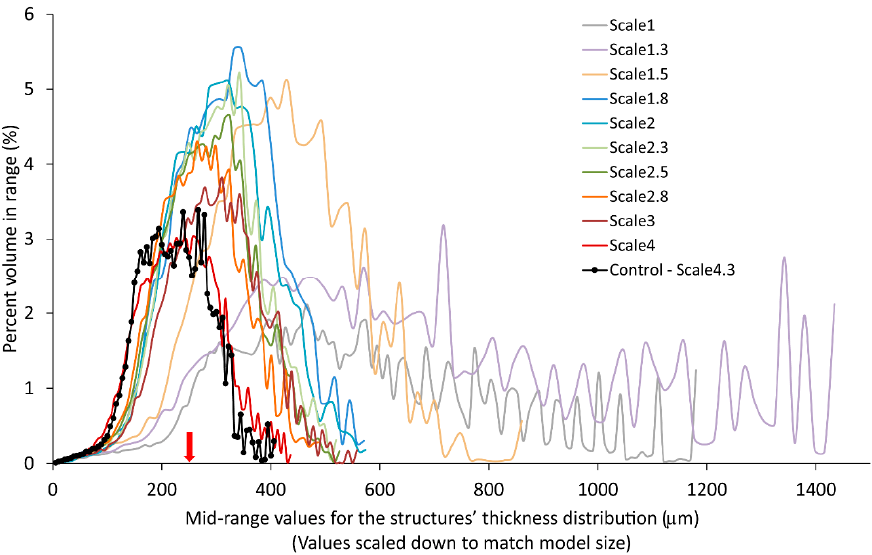
Figure 4. Trabecular thickness distributions for trabecular samples printed in Black resin. The mean for the distribution of the trabecular thickness in the 3D model is 246 µm (marked by a red arrow) [13].